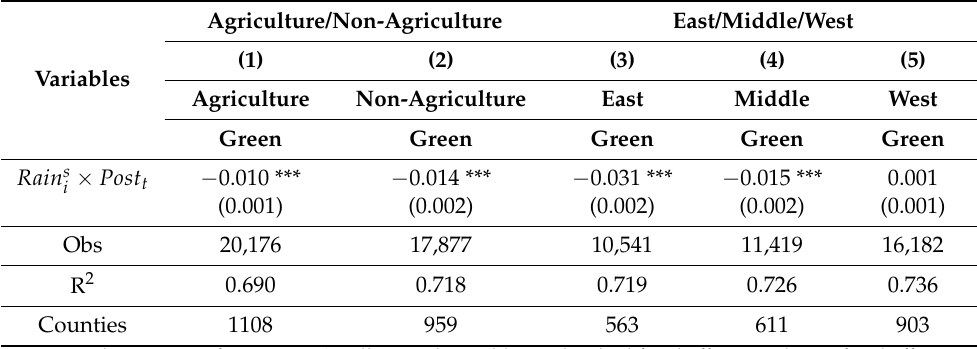
Table 8. Heterogeneity analysis 2: Industrial structures and economic